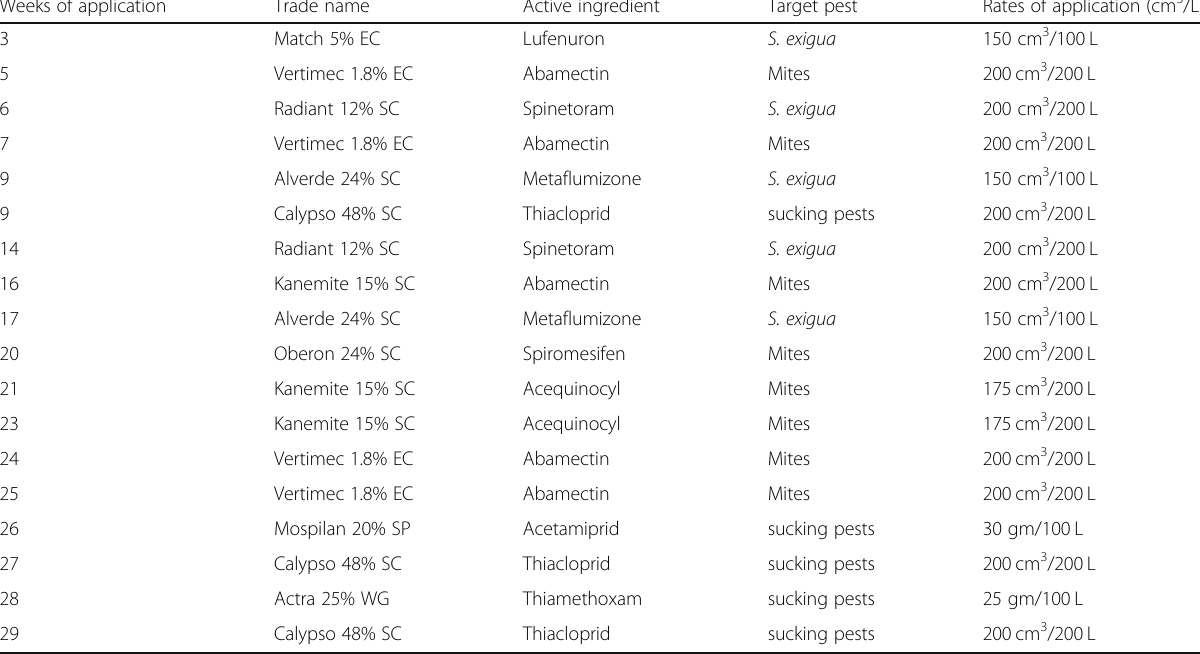
Table 1 A list of pesticides applied to control sweet pepper pests in the greenhouse from September 8, 2016 to March 26, 2017 Weeks of application